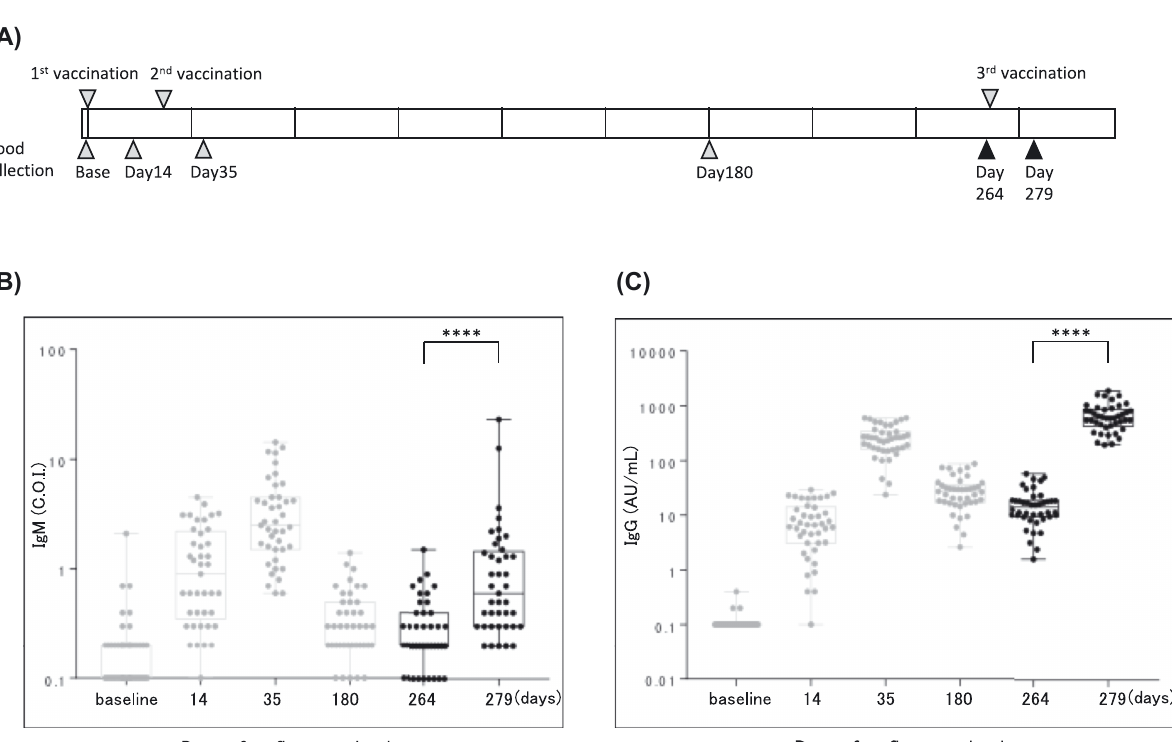
Figure 1: Vaccination procedure, sampling and antibody titers. (A) Schematic presentation of sampling procedures (B and C). Box plots of anti-SARS-CoV-2 antibody levels following vaccination with the BNT162b2 vaccine. (B) Anti-SARS-CoV-2 IgM titer 264 and 279 days after the fi rst vaccination in all participants. (C) Anti-SARS-CoV-2 IgG titer 264 and 279 days after the fi rst vaccination in all participants. Data are shown as boxplots representing the 25th percentile, 75th percentile, median, and 95% con fi dence interval using Prism software (version 7.0; GraphPad Software Inc., La Jolla, CA, USA). ****p<0.0001. Data at baseline, day 14, 35 and 180, are shown in gray, presented for